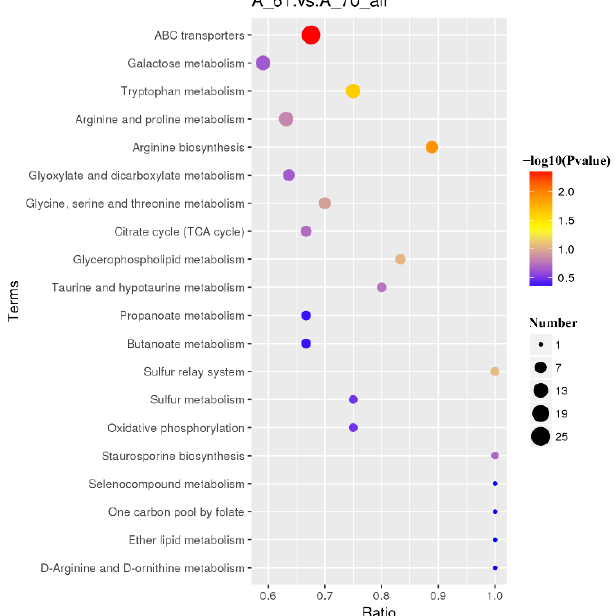
Figure 14. Bubble chart of KEGG enrichment results of differential metabolites between mutant 61 and mutant 70. The size of the bubble indicates the number of genes enriched in the pathway.